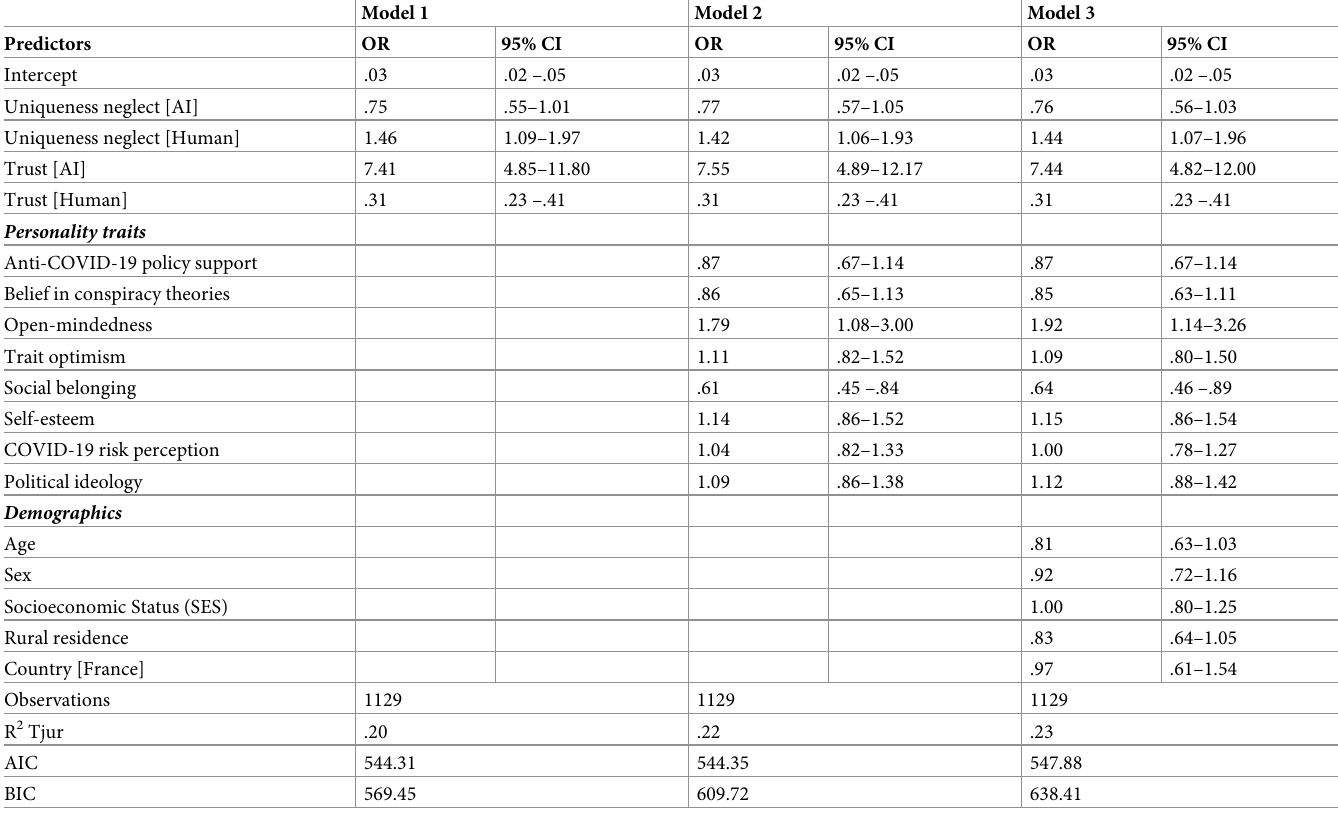
Table 2. Summary of logistic regression models on adoption of medical